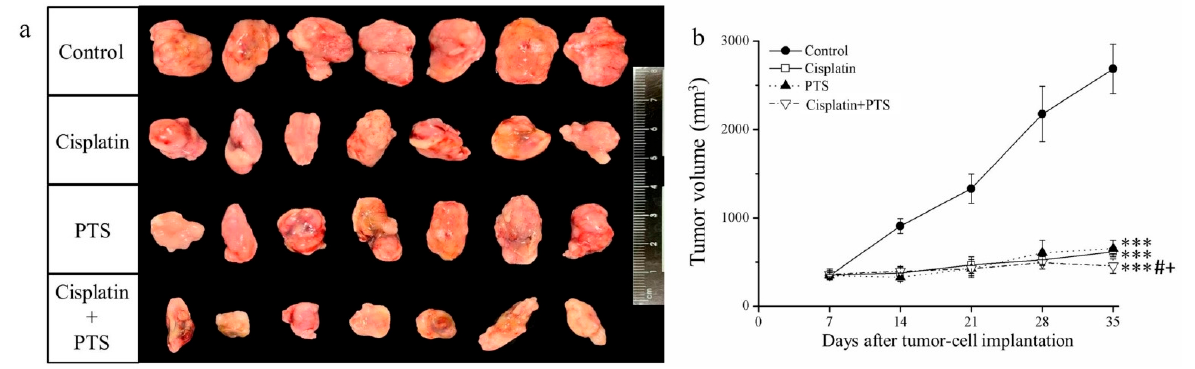
Figure 1. Effects of treatment with cisplatin, para-toluenesulfonamide (PTS), and their combination on M5 canine melanoma tumor growth in BALB/c nude mice. ( a ) Tumors excised from the mice 35 days after tumor-cell implantation. ( b ) Change in tumor volume over time. Treatments were administered from day 7 (when the tumors were detected) three times per week, as follows: saline (control), 2 mg/kg cisplatin (cisplatin), 100 mg/kg PTS (PTS), and 100 mg/kg PTS combined with 2 mg/kg cisplatin (cisplatin + PTS). Data are presented as mean ± standard deviation (SD), n = 7 per group. *** p < 0.001 vs. control; # p < 0.05 vs. cisplatin; + p < 0.05 vs. PTS. Table 1. Tumor masses after excision from sacrificed BALB/cByJNarl mice. Tumor Mass (g) Tumor Mass Reduction (%)